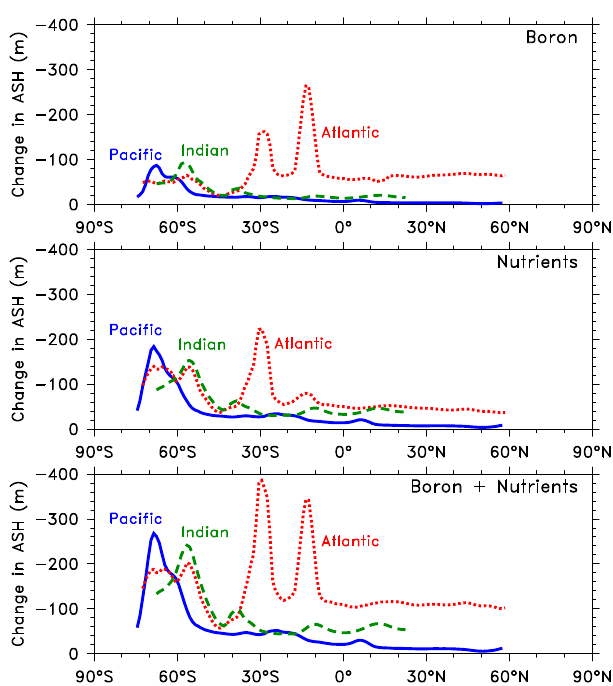
Figure 12. Changes in the aragonite saturation horizon (ASH) due to (top) using the new formulation of total boron (Lee et al. mi- nus Uppström), (middle) accounting for nutrient alkalinity (relative to the common simplification where it is neglected), and (bottom) summing both corrections. Changes in ASH (m) are smoothed over 5 ◦ bands of latitude and shown as zonal means over the Atlantic, Pa- cific, and Indian Oceans. The peaks at 30 and 12 ◦ S in the Atlantic are caused by subtle shifts in horizontal gradients of (cid:127) A